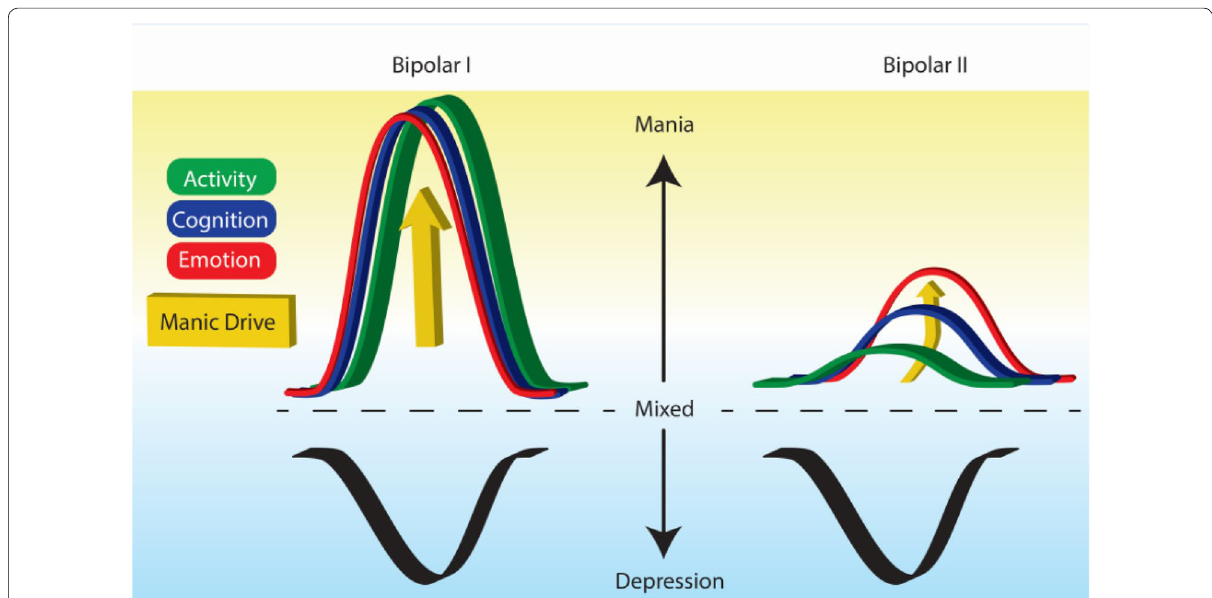
Fig. 1 ACE Model of mania. This schematic shows how manic drive, perhaps through differential action on different symptomatic domains can create a seemingly separate phenotype when in fact the difference in manifestation is largely because of the inherent properties of different neurocognitive schema and neural systems within the brain. In florid mania, manic drive (shown in yellow) is so extreme that irrespective of the inherent rigidity of various domains, they are all extended (akin to elastic bands) to the same extent. And so, activity, cognition and emotion are all impacted equally and symptoms from each of these domains are evident. However, when manic drive is more modest, those domains that are inherently more pliant are impacted first and hence why there is separation between emotion, cognition and activity. Emotion, by its very nature is more malleable and variable, whereas cognition succumbs more slowly, and activity is the most hard-wired and therefore requires significant manic drive before it is impacted. The figure also shows that lesser degrees of variation and more subtle changes lead to a more mixed presentation in which features of both mania and depression exist alongside each other, by virtue of belonging to independent domains (ACE). This schematic then explains how ‘bipolar II’ and other putative subtypes could perhaps be created and yet have the same underlying mechanisms and therefore, in essence, remain the same